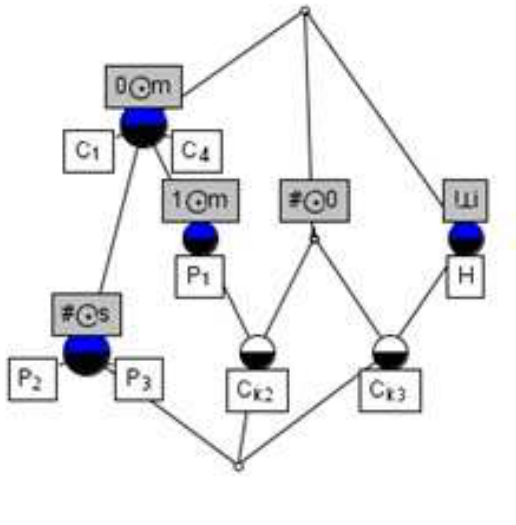
Figure 10. The concept lattice of Table 5. Table 9. The Coh value of a sets of cylinder.